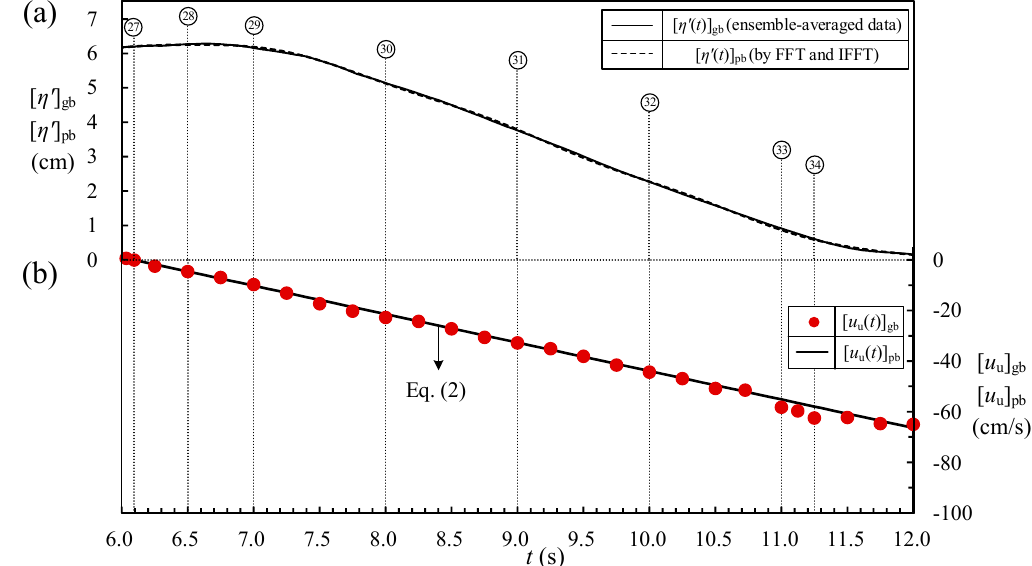
Figure 15. Temporal variations of ( a ) [ η ′ ( t )] gb and [ η ′ ( t )] pb ; ( b ) [ u u ( t )] gb and [ u u ( t )] pb obtained at SMS for 6.094 s ≤ t < 12.000 s. Note that times changing from circled 27 to 34 are shown in sub-table of Figure 7a,b.